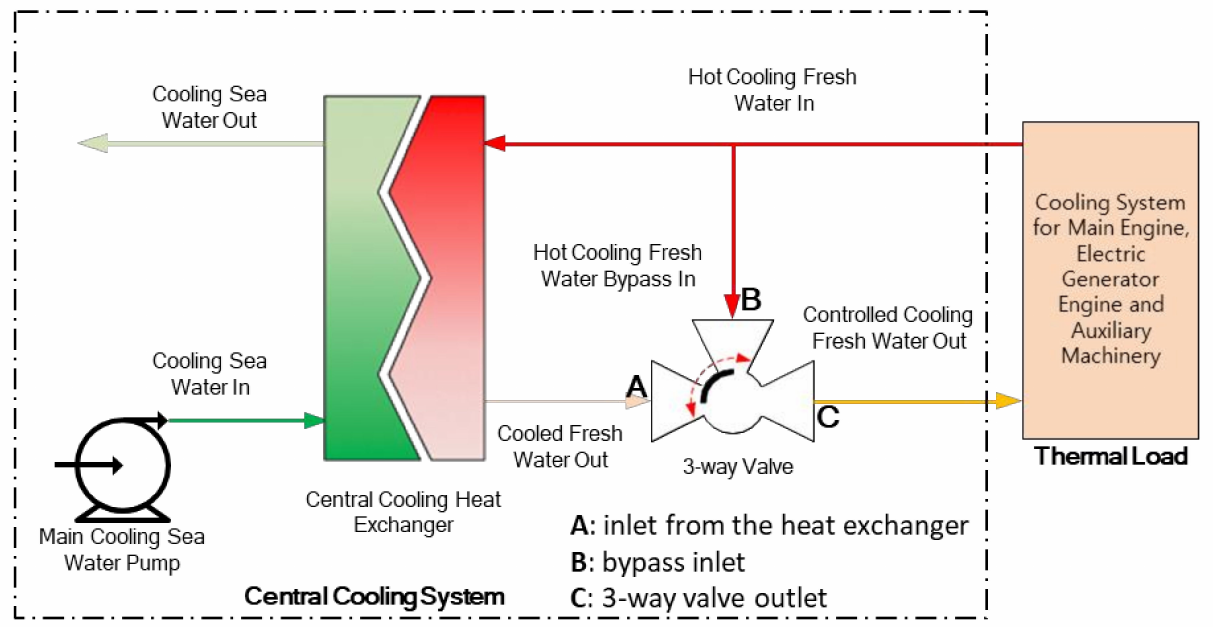
Figure 1. Central FW cooling